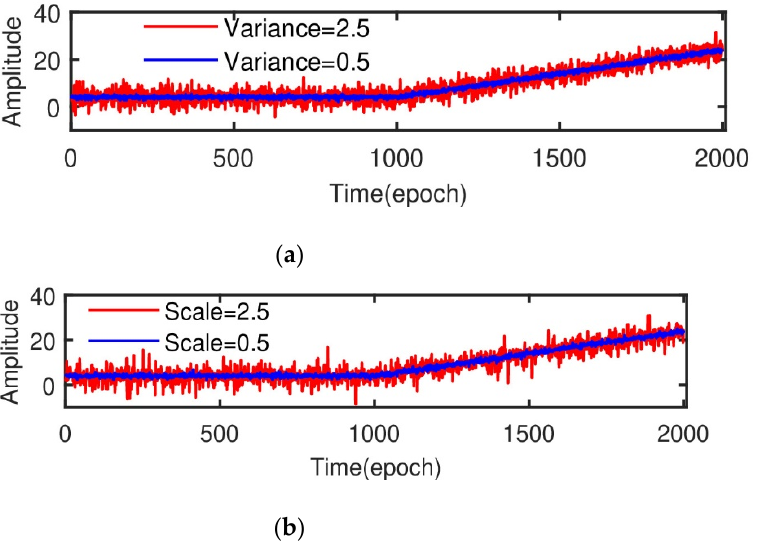
Figure 3. Variation of the amplitude of synthetic data simulating ionospheric anomalies with Gaussian noise ( a ) and Laplacian noise ( b ). The ionospheric gradient anomalies are simulated from the 1001st epoch by adding ramp-type errors. The absolute maximum values of noise in ( a ) are 1.7 m (variance = 0.5) and 6.9 m (variance = 2.5). The absolute maximum values in ( b ) are 1.9 m (scale = 0.5) and 9.6 m (scale = 2.5).